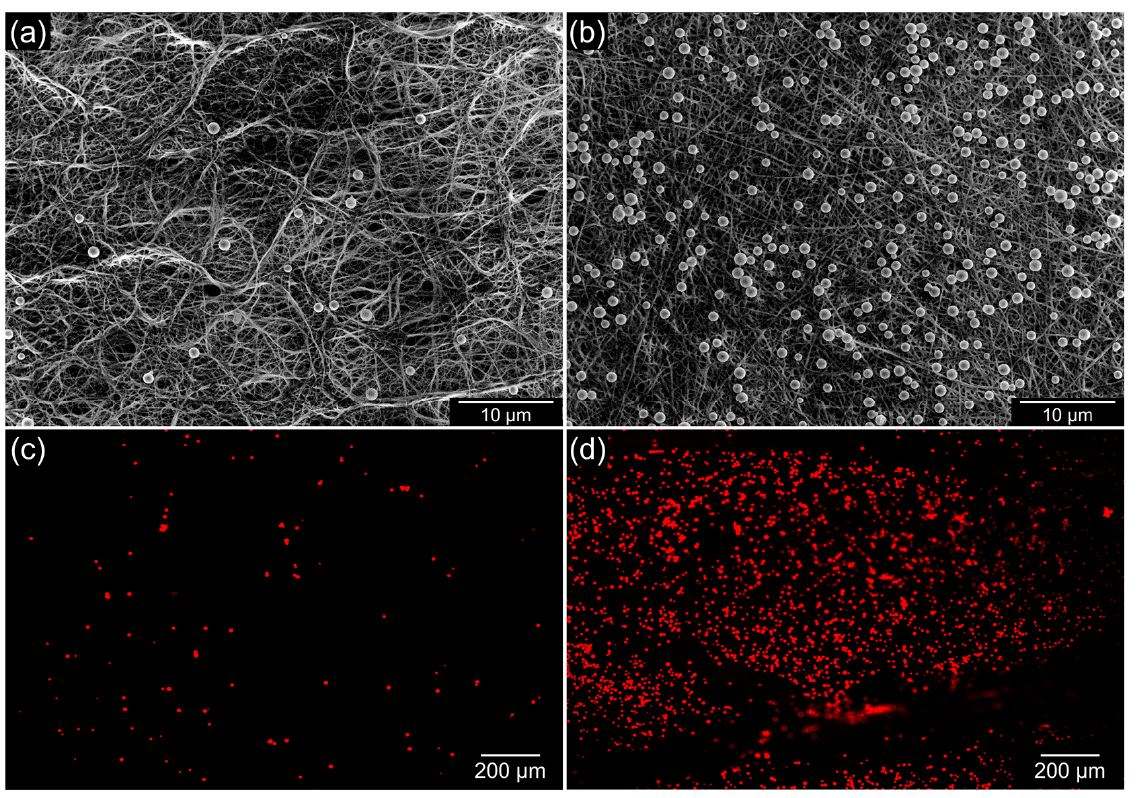
Figure 3. Results of trapped beads on each side of bilayer membrane. ( a , b ) SEM images and ( c , d ) fluorescent images of residual beads.